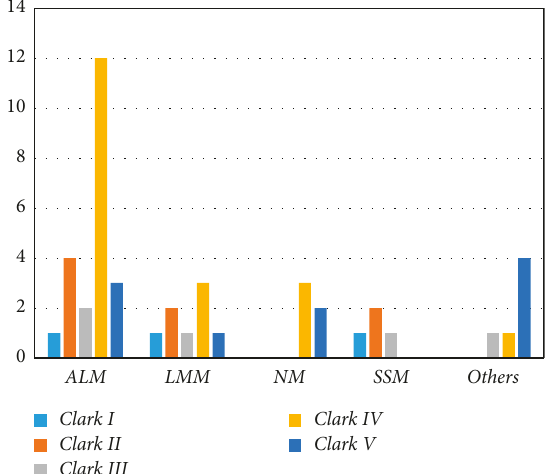
Figure 4: Clark’s invasion level in different types of